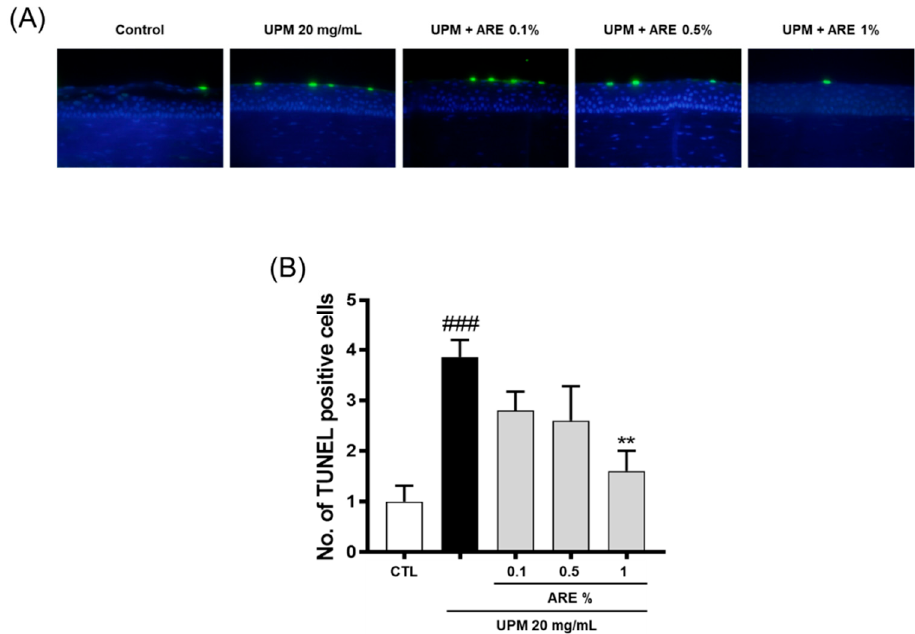
Figure 4. Topical administration of Achyranthis radix extract reduced apoptosis of the corneal epithelium. ( A ) Apoptosis of corneal epithelial cell was evaluated using TUNEL assay. ( B ) Each bar represents the mean number of TUNEL-positive cells ± SEM, n ≥ 5. ### p < 0.001 vs. control group, ** p